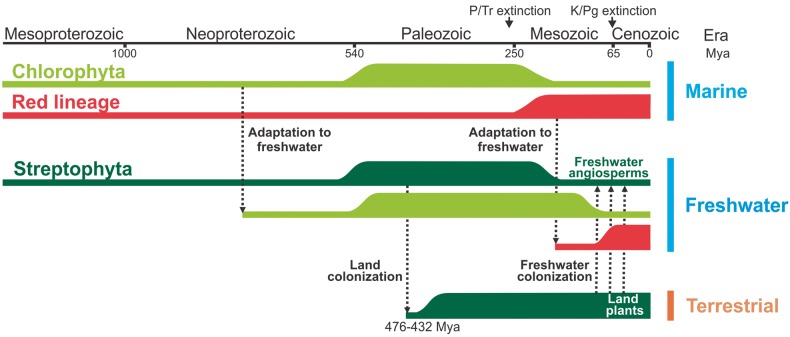
Schematic representation of the colonization of the main habitats by eukaryotic phototrophs and their diversification and variations in abundance during evolution. The heights of the horizontal bars indicate relative abundances according to Leliaert et al. (2011), Falkowski et al. (2004), and Becker and Marin (2009). The timeframes of the different events are approximate. The transition of streptophytes from terrestrial to freshwater habitats occurred several times during evolution. P/Tr extinction, End-Permian or Permian-Triassic mass extinction; K/Pg extinction, Cretaceous/Paleogene extinction (dinosaurs).